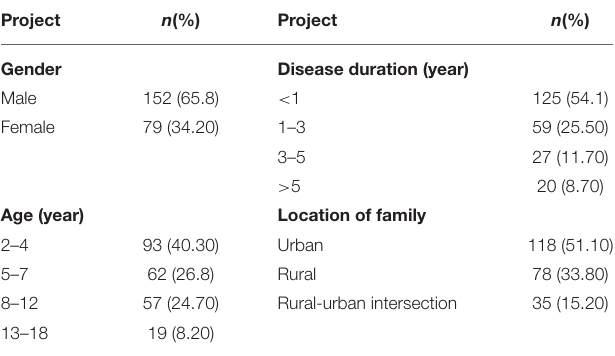
TABLE 1 | The general characteristics in the children with nephrotic